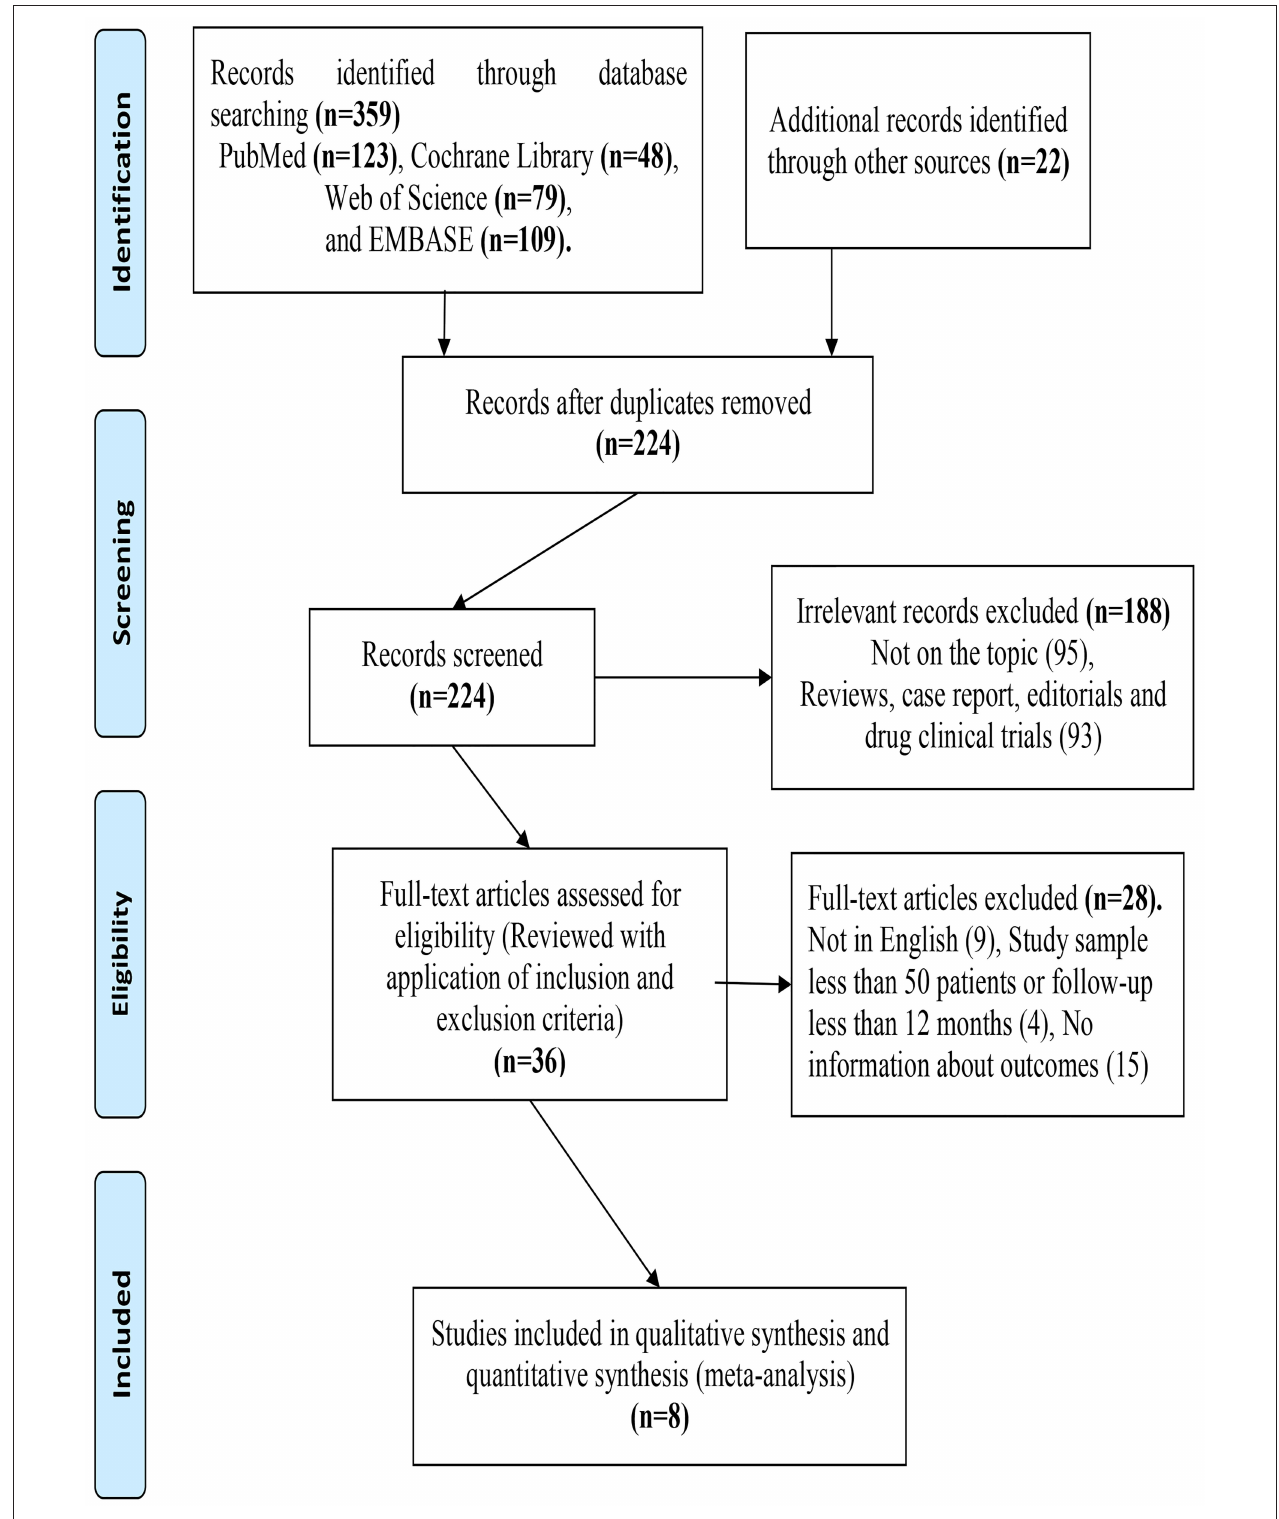
FIGURE 1 | PRISMA flow chart of the data search.